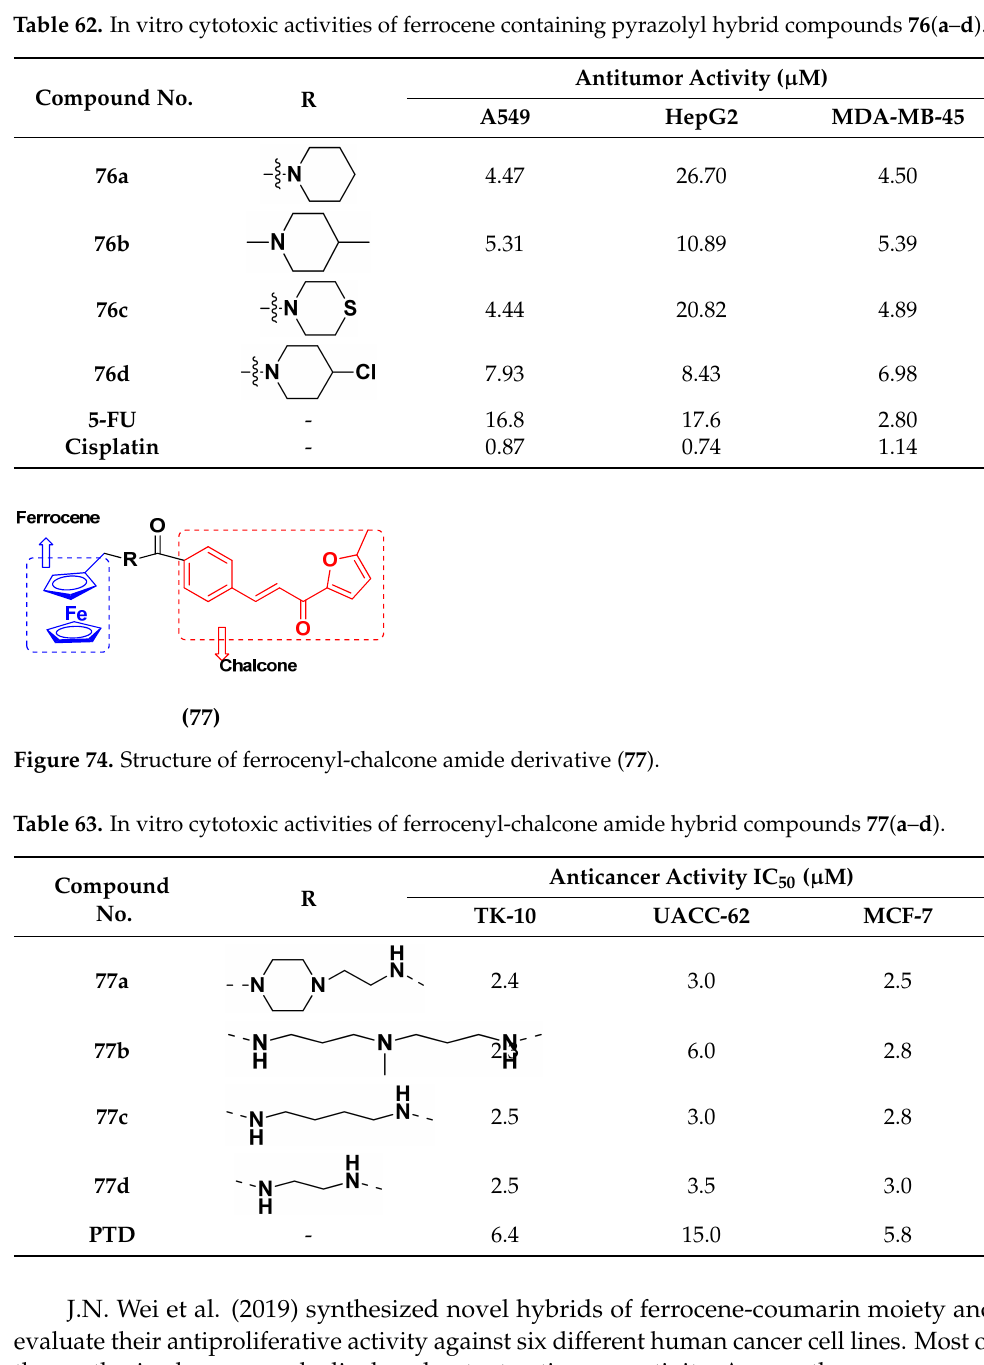
Figure 75. Structure of ferrocene ‐ coumarin moiety derivative ( 78 ).